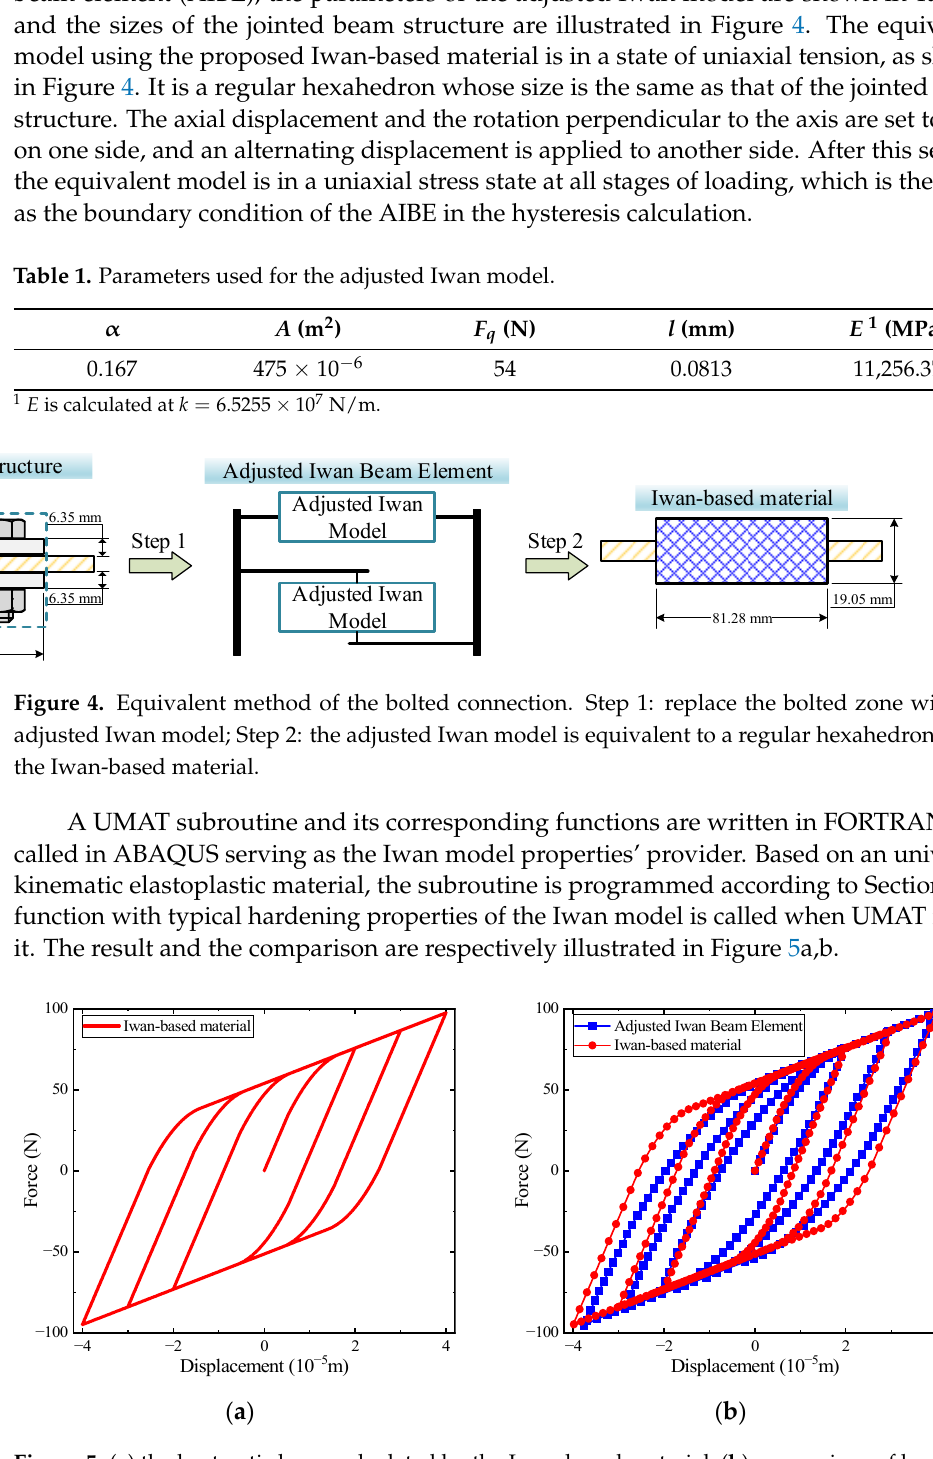
Figure 5. ( a ) the hysteretic loops calculated by the Iwan-based material; ( b ) comparison of hysteretic loops obtained by two modeling methods.